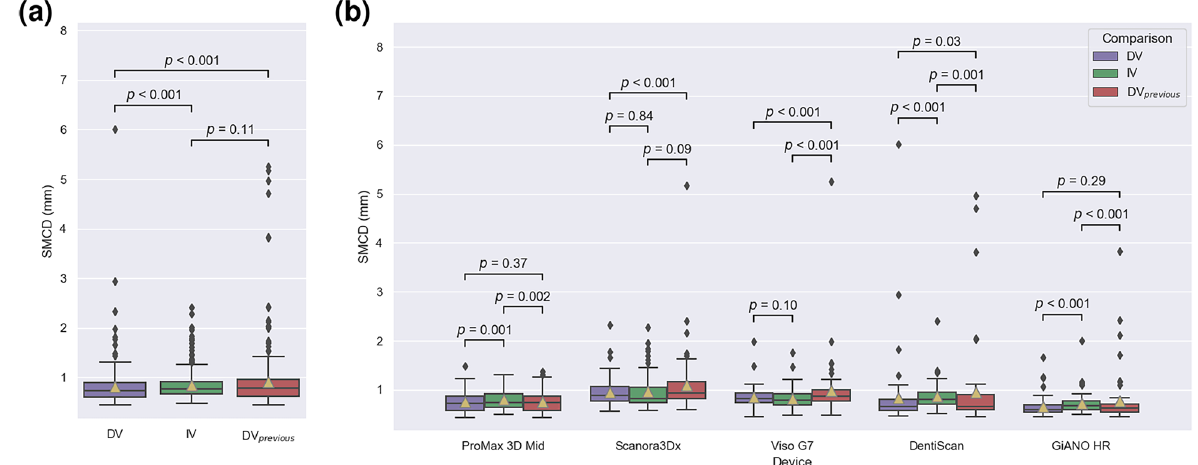
Figure 4. Tukey’s boxplot comparison of interobserver variability (IV), DLS to expert variability (DV), and previous method 4 to expert variability (DV previous ), measured in symmetric mean curve distance (mm). Statistical significance measured with Wilcoxon signed-rank test. ( a ) Comparison of full test dataset (N = 300). ( b ) Device- wise comparison between the groups (N = 60 per